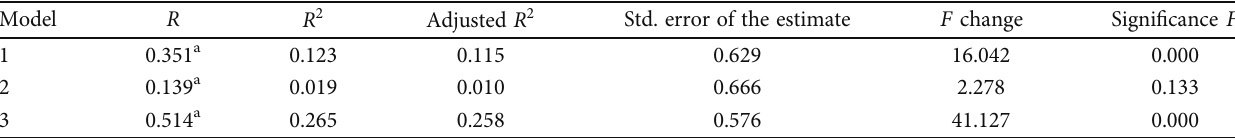
Table 6: Regression model summary b .